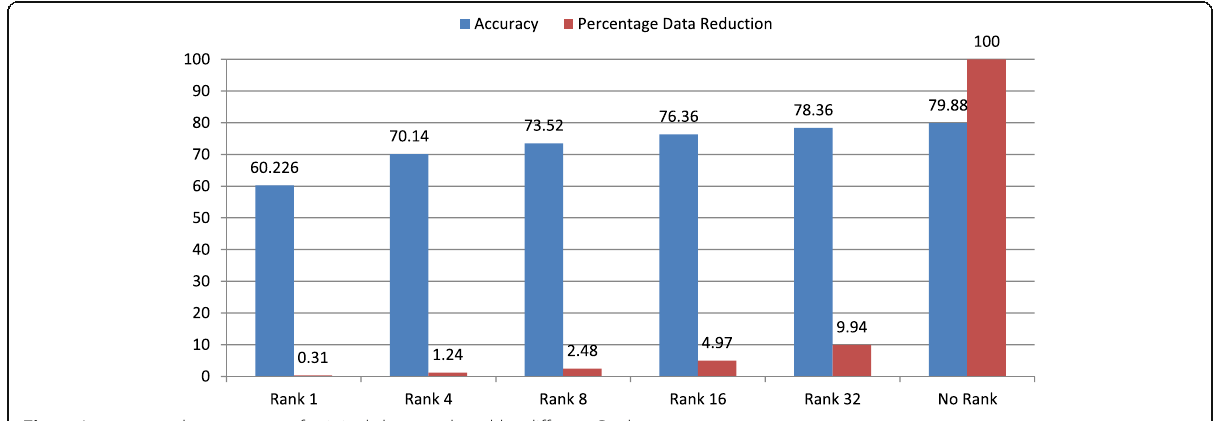
Fig. 5 Accuracy and percentage of original data produced by different Ranks